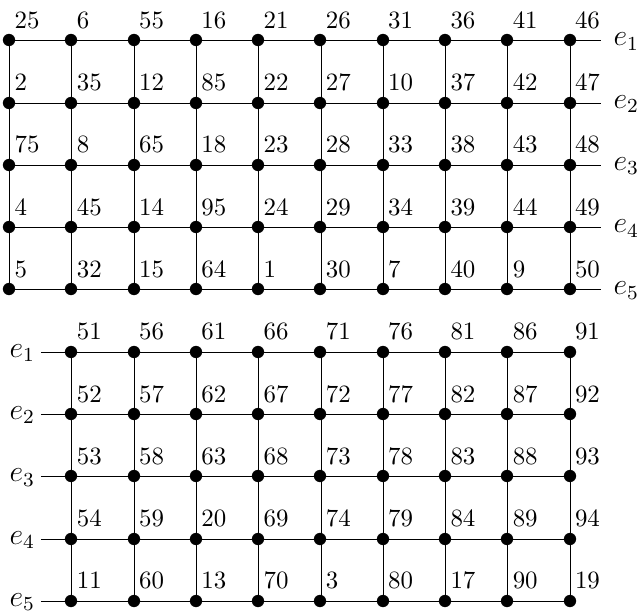
Figure 3: Prime labeling on P